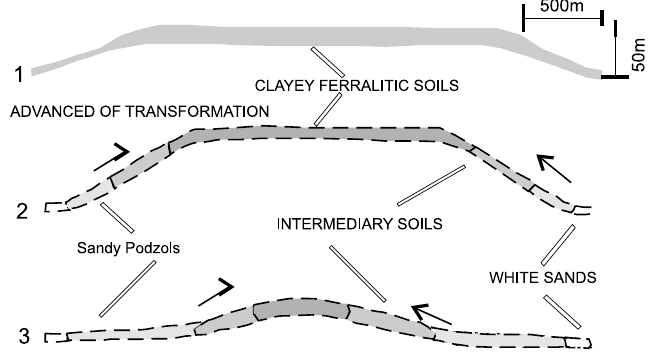
Fig. 7 – Stages of evolution of the lateritic – podzol soil systems in the Amazon Basin (Melfi et al. 1999).